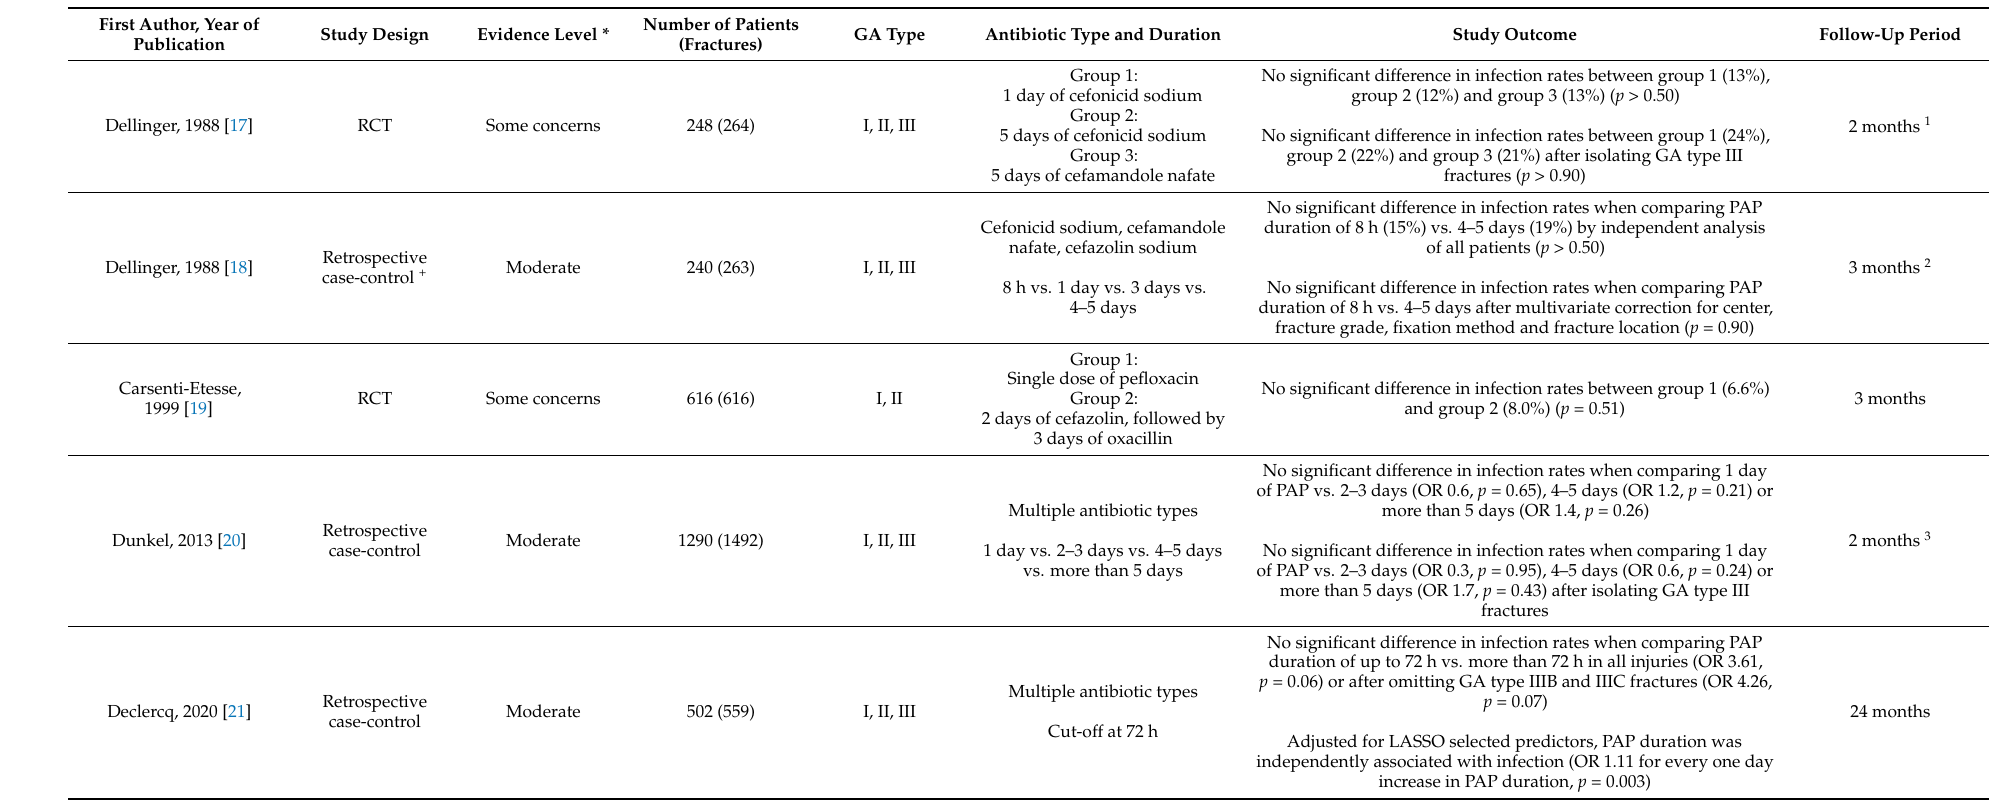
Table 1. Characteristics of eligible